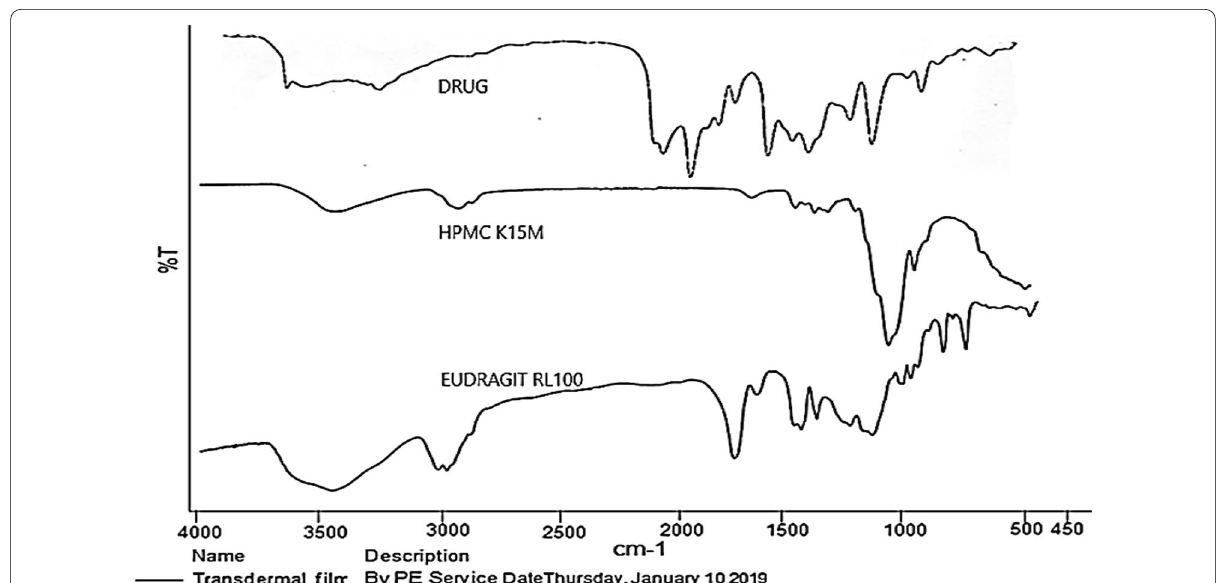
Fig. 3 IR graph of polymer matrix type transdermal patch